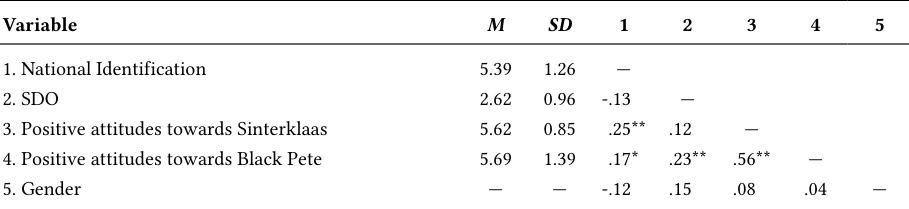
Means, Standard Deviations, and Correlations Between National Identification, SDO, Positive Attitudes Towards Sinterklaas, and Positive Attitudes Towards Black Pete Variable M